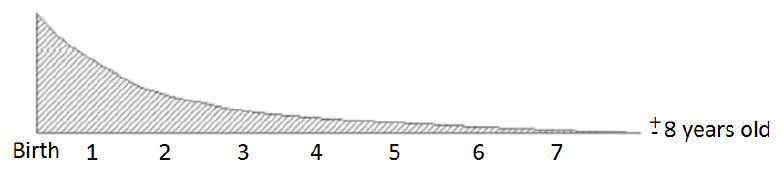
Figure 1. Sensitivity curve for development and